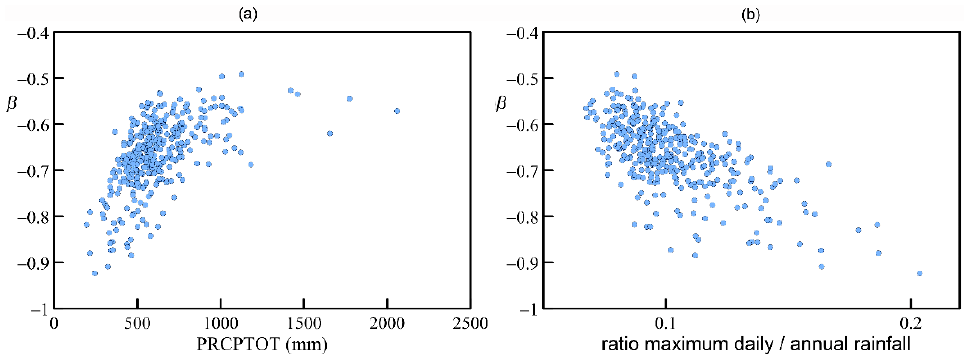
Figure 5. Empirical values of the scaling parameter β at every station.